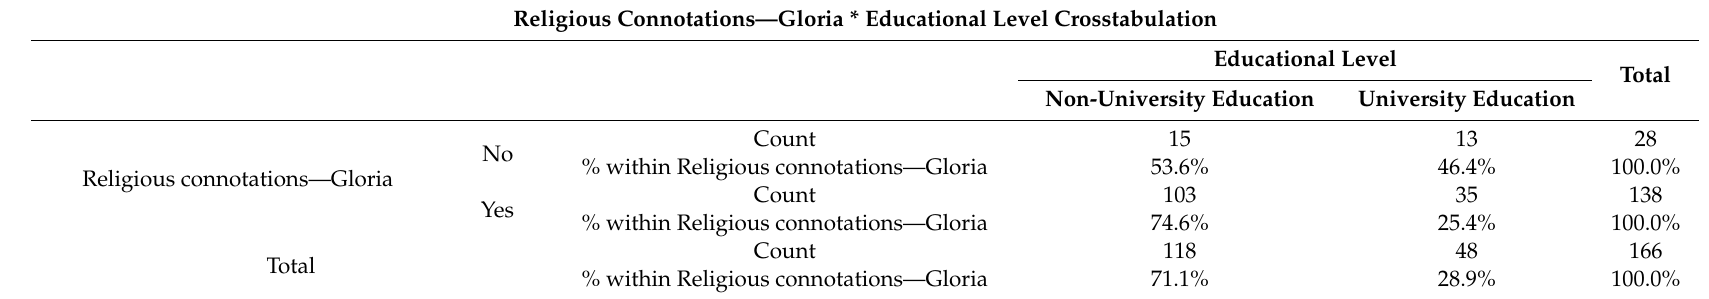
Table 7. Religious connotations in terms of educational level for the name Gloria in the metropolitan district of